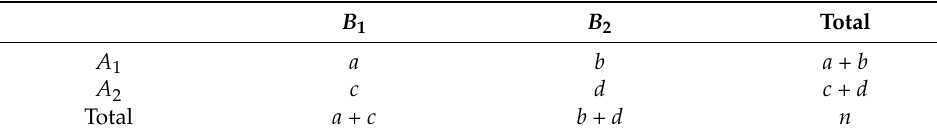
Table 2. 2 × 2 contingency